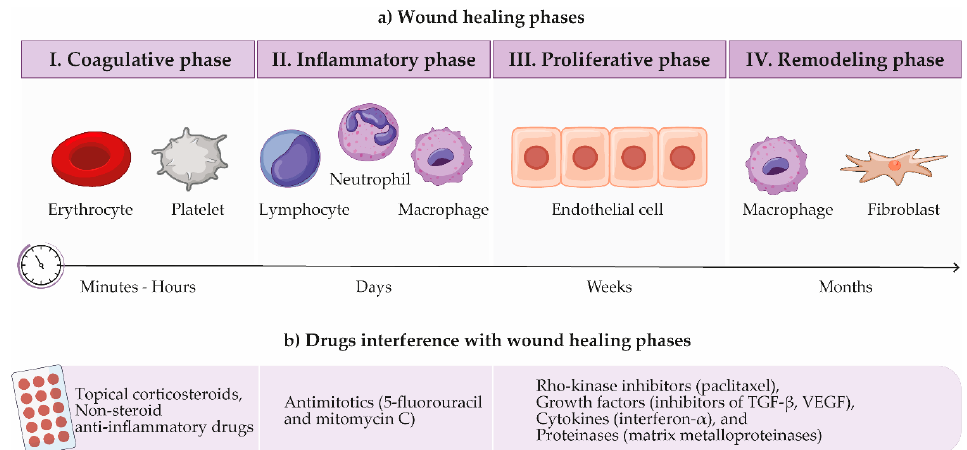
Figure 2. Schematic overview of the process of wound healing ( a ) and drugs that interfere with these phases ( b ). Note: TGF- β : transforming growth factor- β ; VEGF: vascular endothelial growth factor.